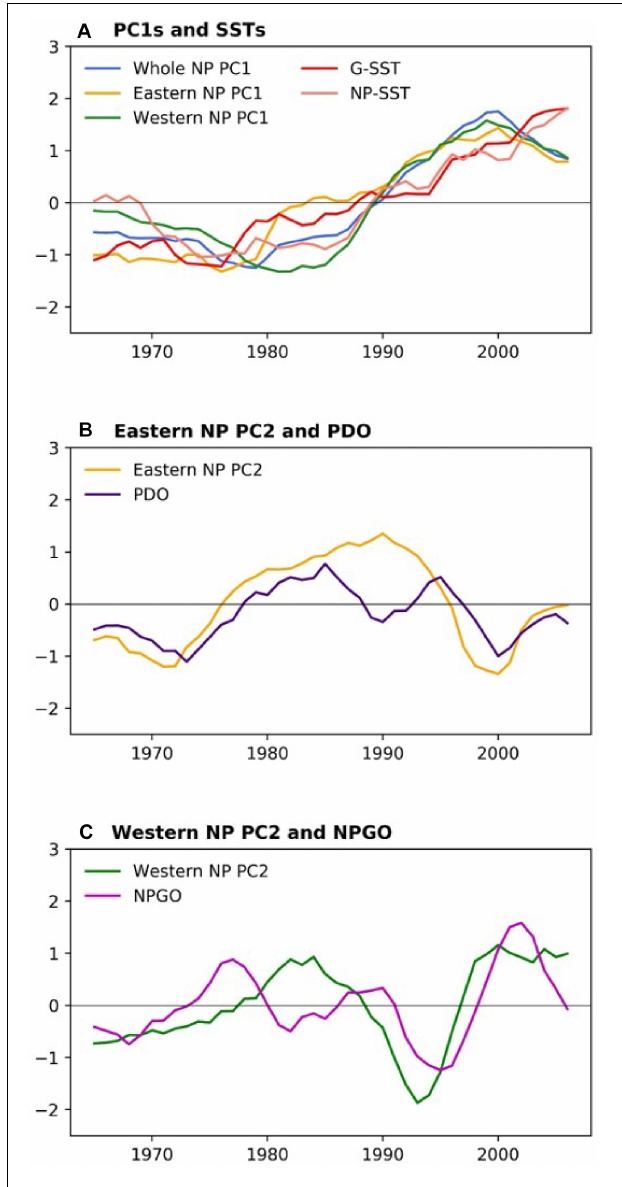
FIGURE 6 | (A) Marine biological PC1s and G-SST and NP-SST (B) eastern NP PC2 and PDO index, and (C) western NP PC2 and NPGO index. From all climate indices, their respective averages in 1965–2006 have been removed, and G-SST and NP-SST are further divided by their respective standard deviations. All time series are smoothed by 5-year running